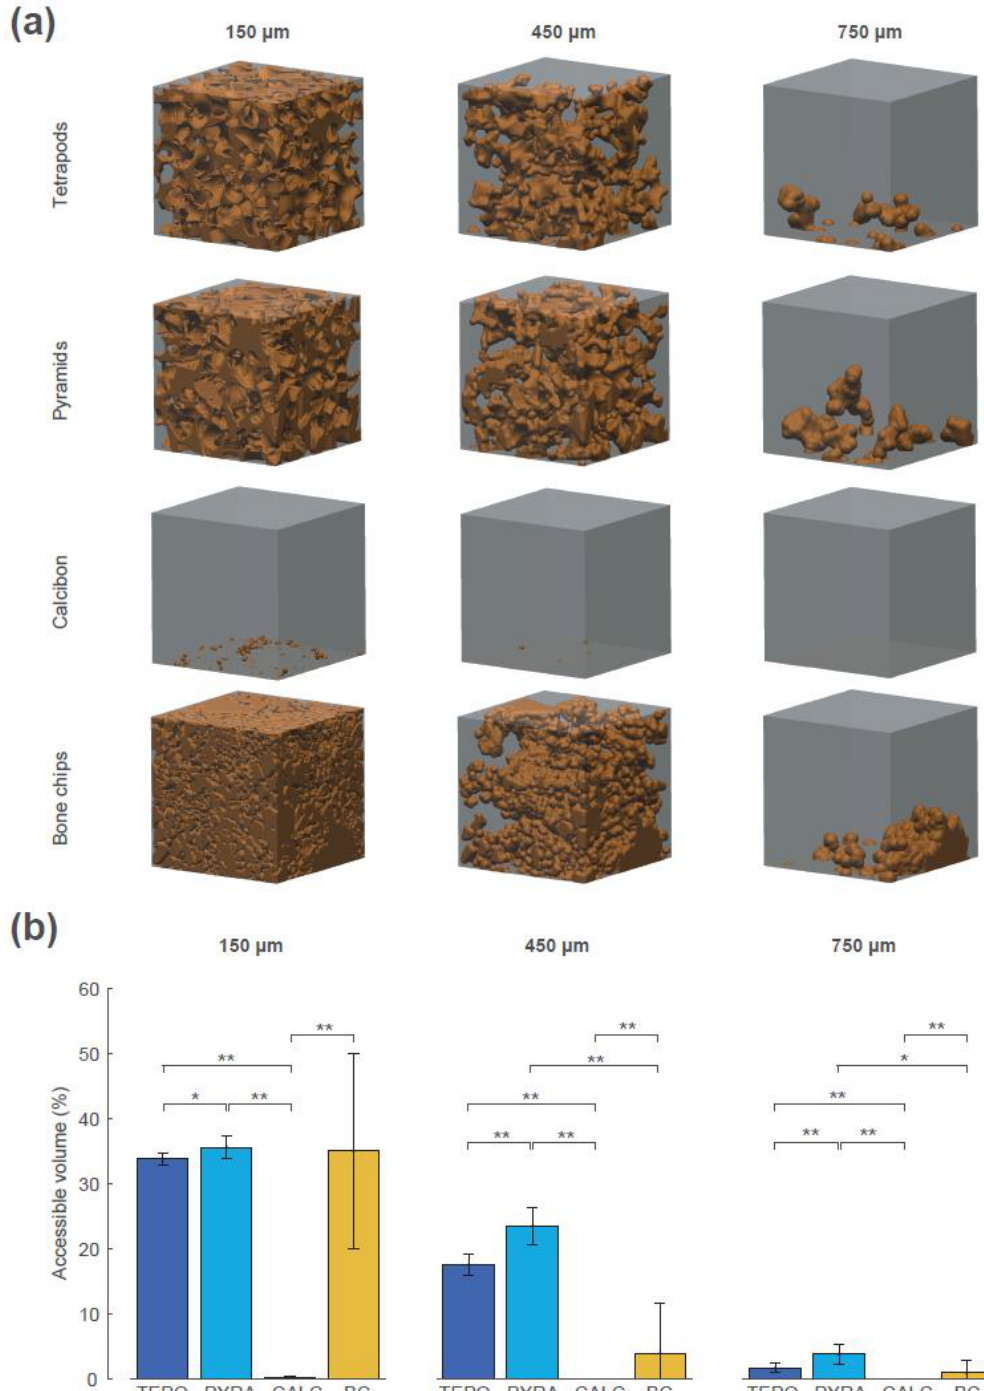
Figure 7. Interconnectivity in terms of accessible volume of the four materials at timepoint t_2 for the virtual object diameters of 150 µm, 450 µm, and 750 µm. ( a ) The accessible volumes of the four materials and the virtual object diameters are graphically shown as brown structures within the regions of interest (ROIs). ( b ) The accessible volumes of the four materials and the virtual object diameters as the ratio between accessible volume, with respect to overall volume in percentage; statistically significant differences are indicated as ∗ = p < 0.05 and ∗∗ = p < 0.01.